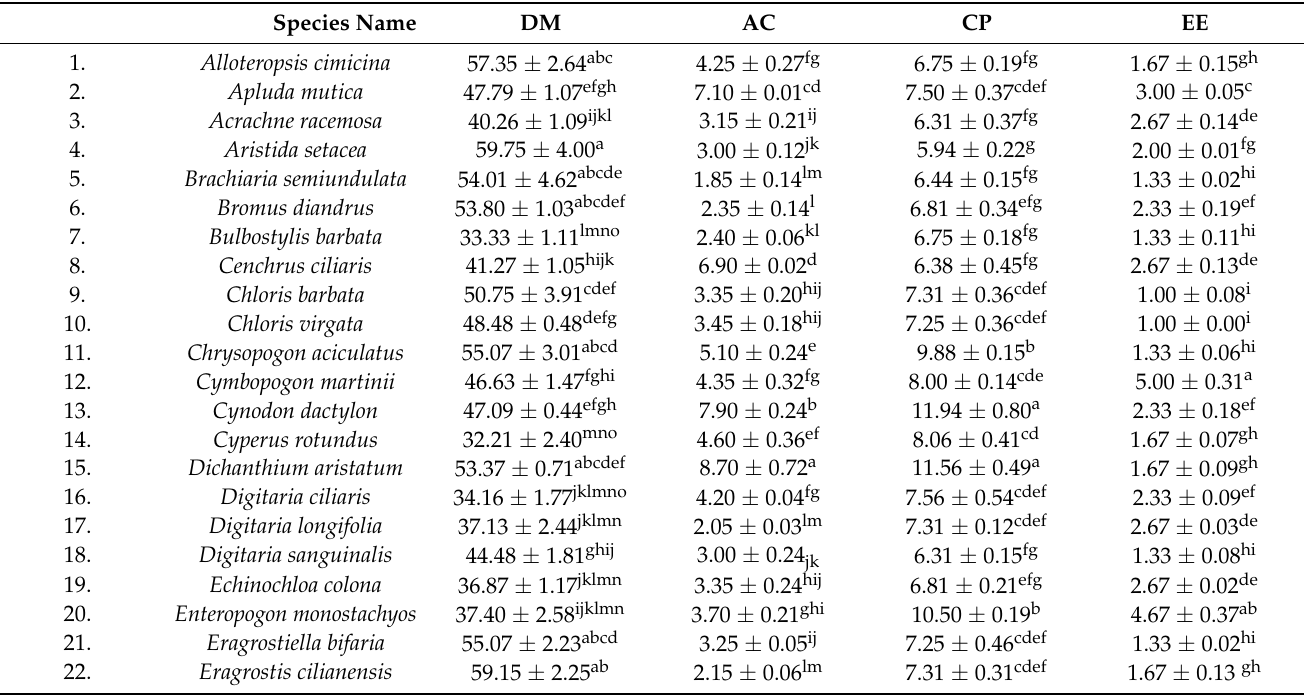
Table 1. Nutritional value of native grass fodder species